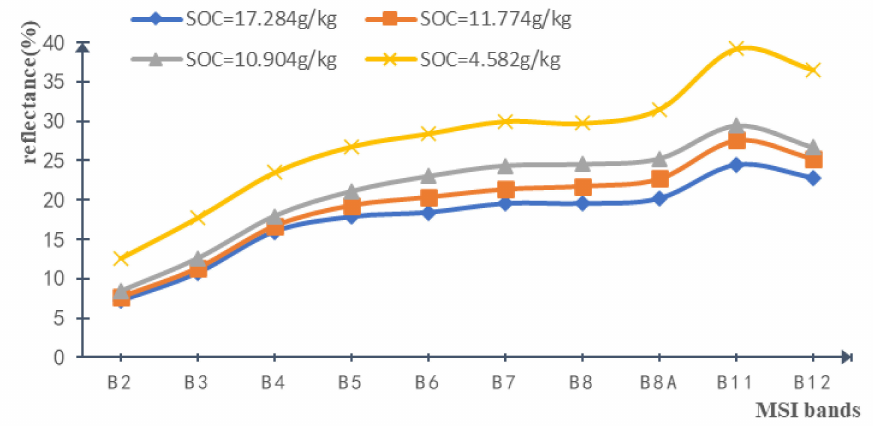
Figure 3. Soil spectral reflectance corresponding to maximum and minimum values of measured soil organic carbon (SOC), as well as to two random values of measured SOC.